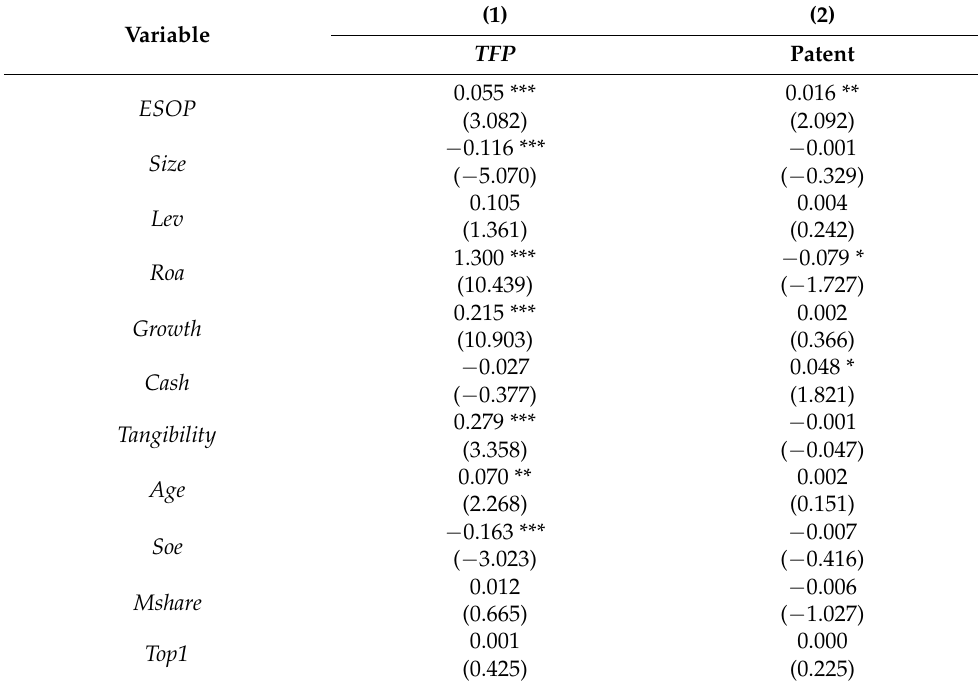
Table 7. Mechanism